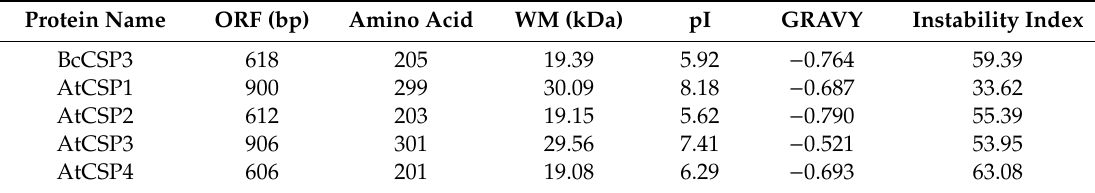
Table 1. General information on cold shock proteins (CSPs).